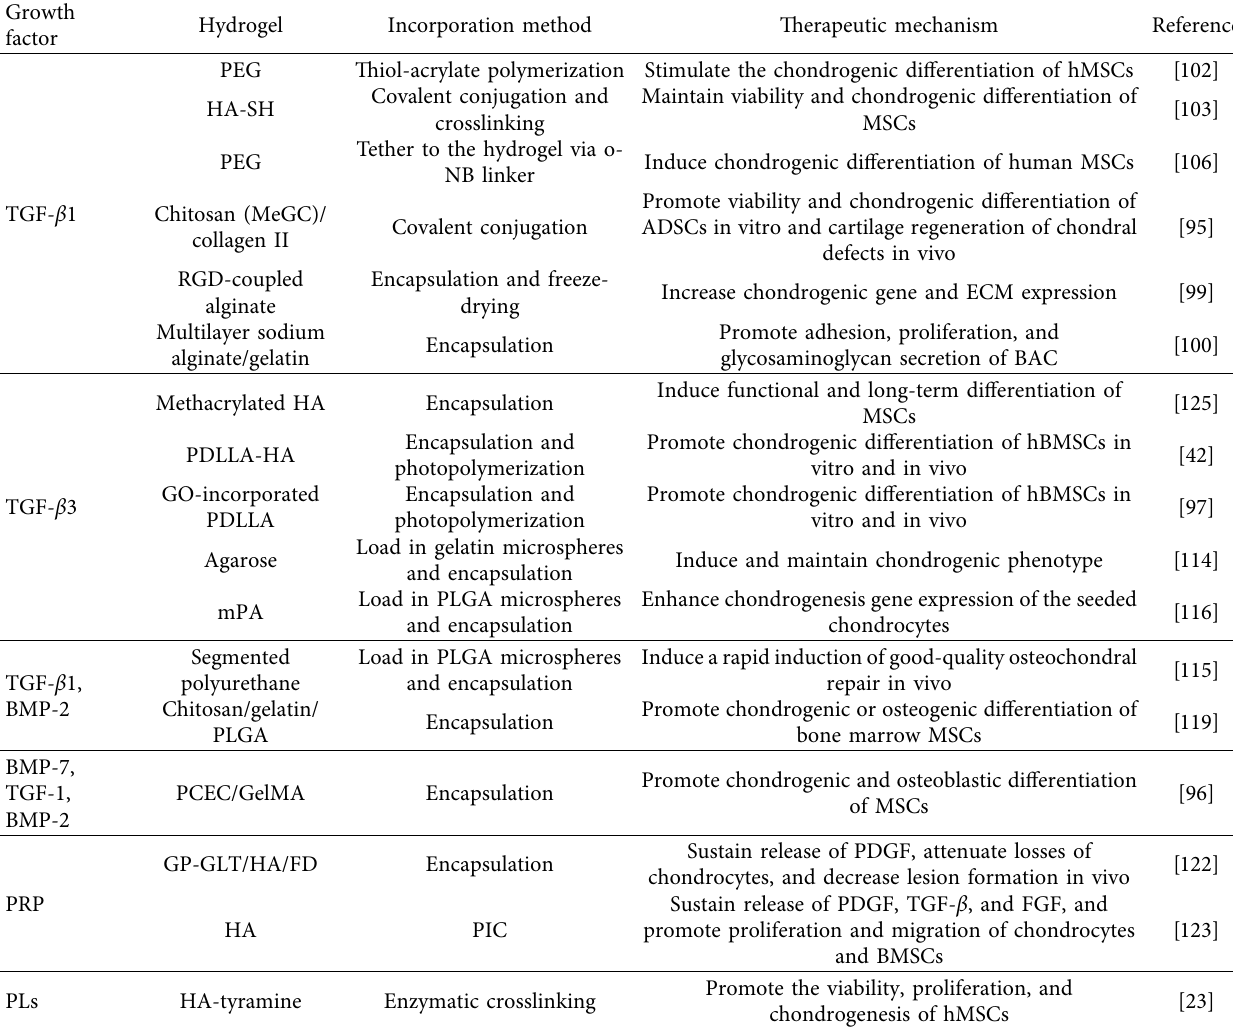
Table 1: Hydrogel used as cartilage regeneration growth factor delivery